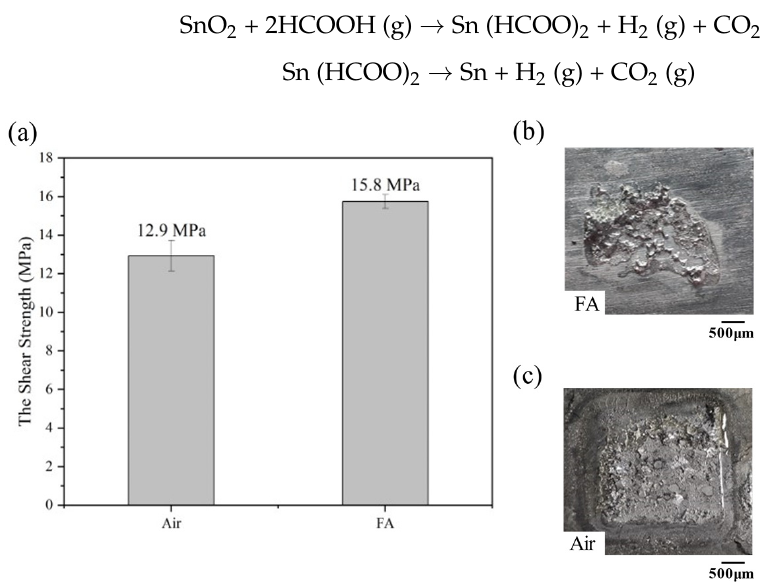
Figure 3. The shear strength and the OM morphologies of the joint under different welding atmospheres: ( a ) statistical data of shear strength; ( b ) the failed solder joint in FA atmosphere after shear strength test; ( c ) the failed solder joint in air after shear strength test.